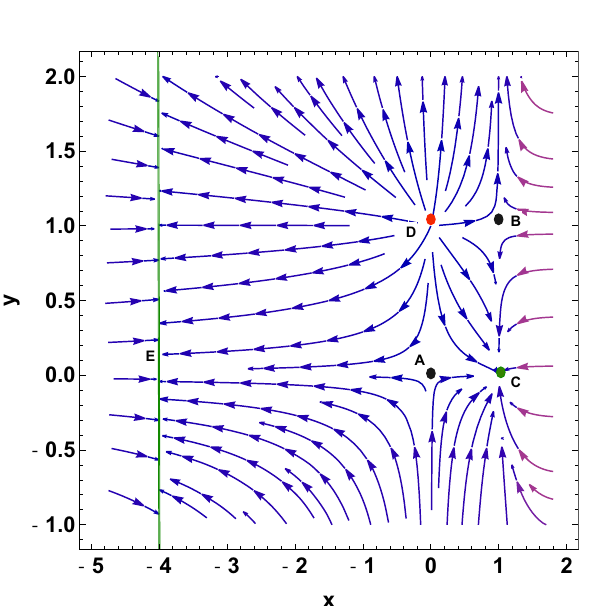
Fig. 2 Phase plot corresponding to the model f ( Q , T ) = α Q + β T 2 with κ =